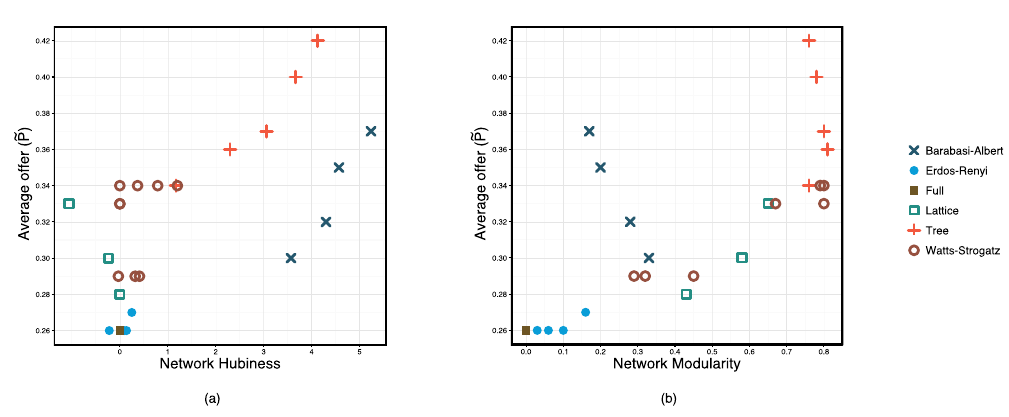
Figure 2. Fairness versus network topology parameters. ( a ) Average offer value vs. network hubiness. ( b ) Average offer value vs. network